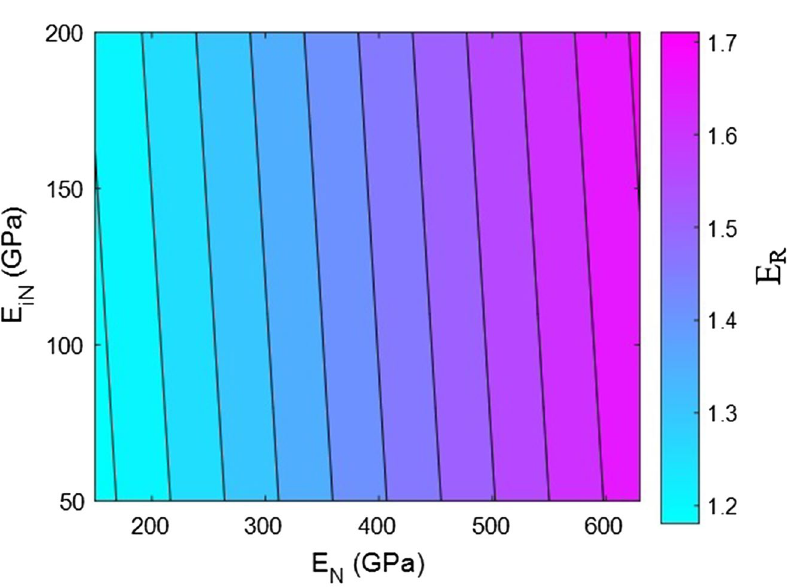
Figure 6. Variation of relative modulus at various moduli of the HNT network and the surrounding interphase zone according to the proposed